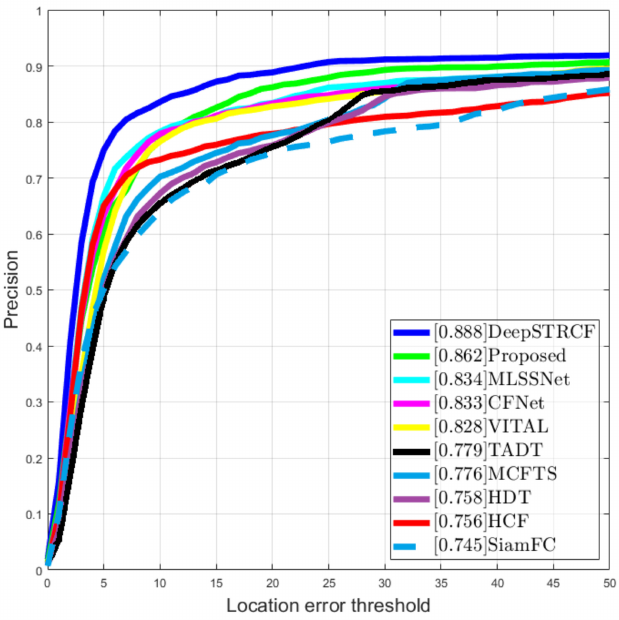
Figure 9. Position precision plot on the PTB-TIR